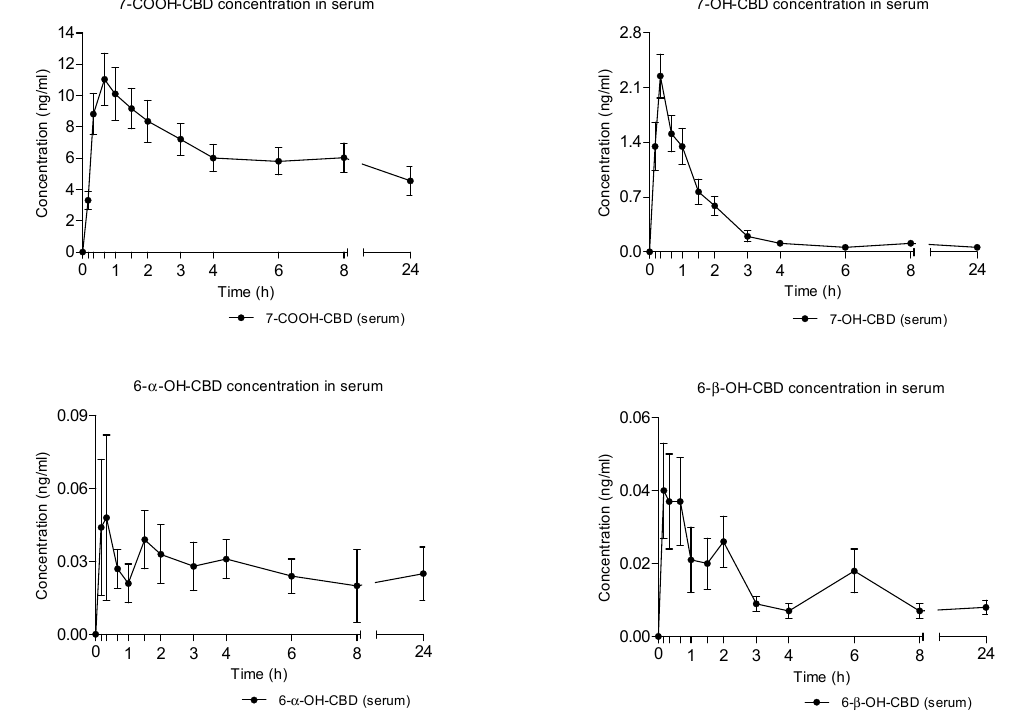
Figure 5. Mean time-course of CBD metabolites concentrations in serum following the administration of vaporized can- nabis. Table 1. Pharmacokinetic parameters of THC, CBD, and their acidic precursors in oral fluid of healthy volunteers admin- istered with 100 mg vaporized medical cannabis.